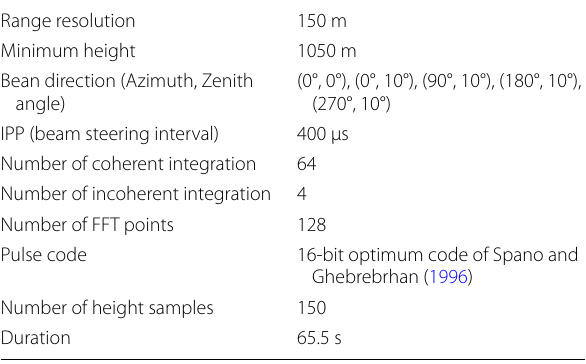
Table 2 Radar parameters for the turbulence echo meas- urements with EAR